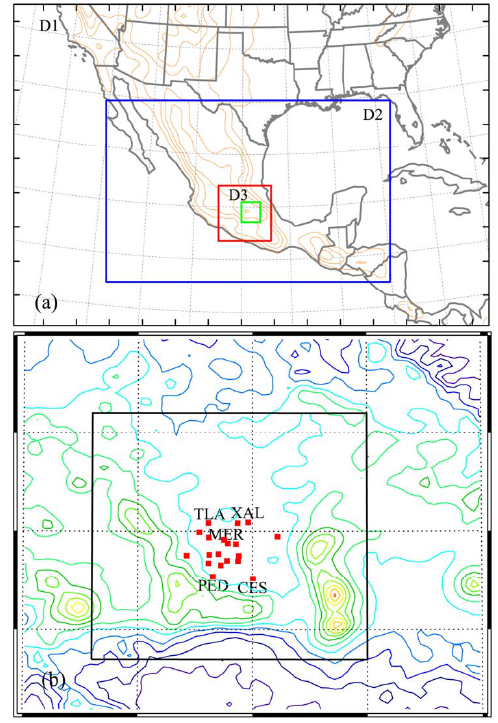
Fig. 1. (a) WRF domains (black, blue, red box) and (b) CAMx domain (green box in Fig. 1a, Square signs are RAMA stations for ozone measurements). Inner box indicates the domain shown in Figs. 6 and 8. Contours in both panels represent terrain